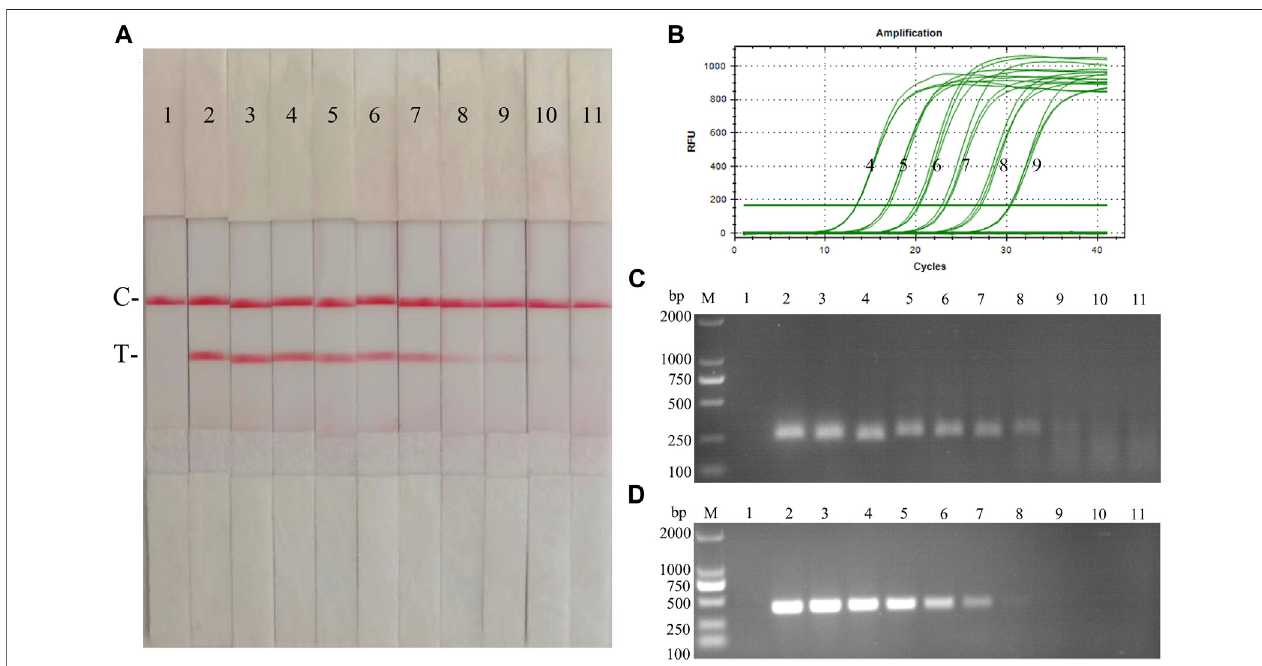
FIGURE9| Recombinant plasmidssensitivityanalysisofCSFVRAA-strip. (A) Thesensitivitytest resultofplasmid copy number byCSFV RAA-stripin order. (B – D) arethatbytheqPCRassay,theRAAagarosegelelectrophoresis assay,andtheconventionalPCRassay.Cisacontrolline.Tisatestline.Misa2,000 bpDNAmarker. Line 1 is the negative control, and the copies of templates used in lane 2 – 11 successively are: 10 10 , 10 9 , 10 8 , 10 7 , 10 6 , 10 5 , 10 4 , 10 3 , 10 2 , and 10 1 copies/ μ L.